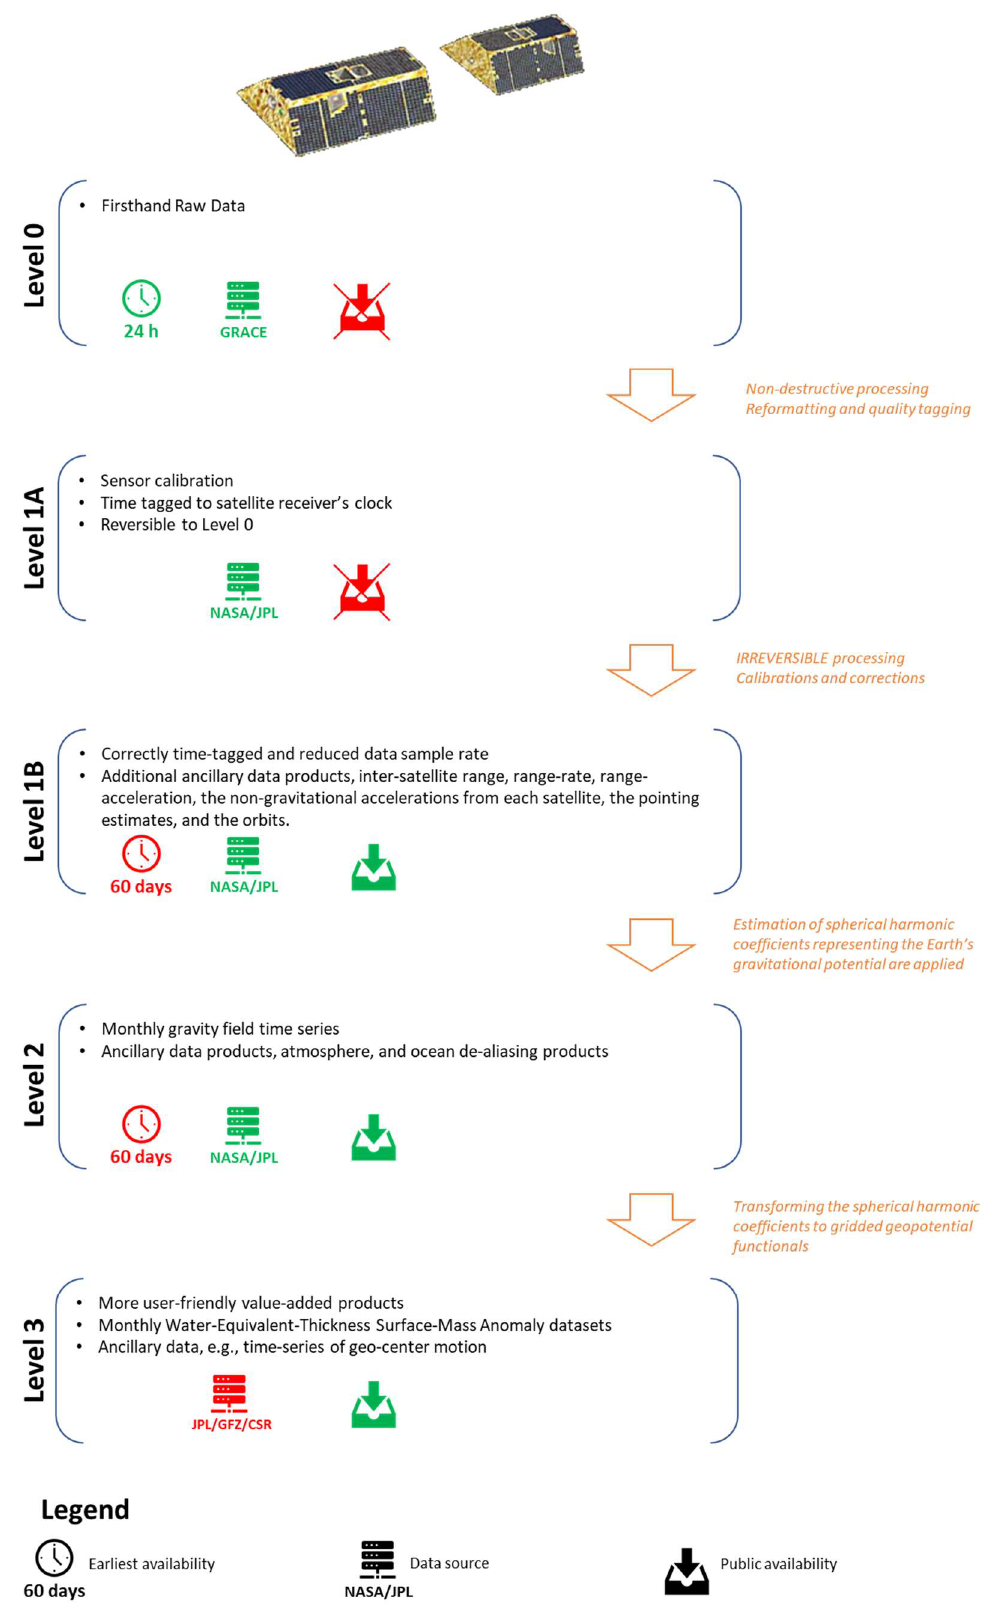
Figure 1. GRACE Satellite Data Levels, characteristics, and processing.